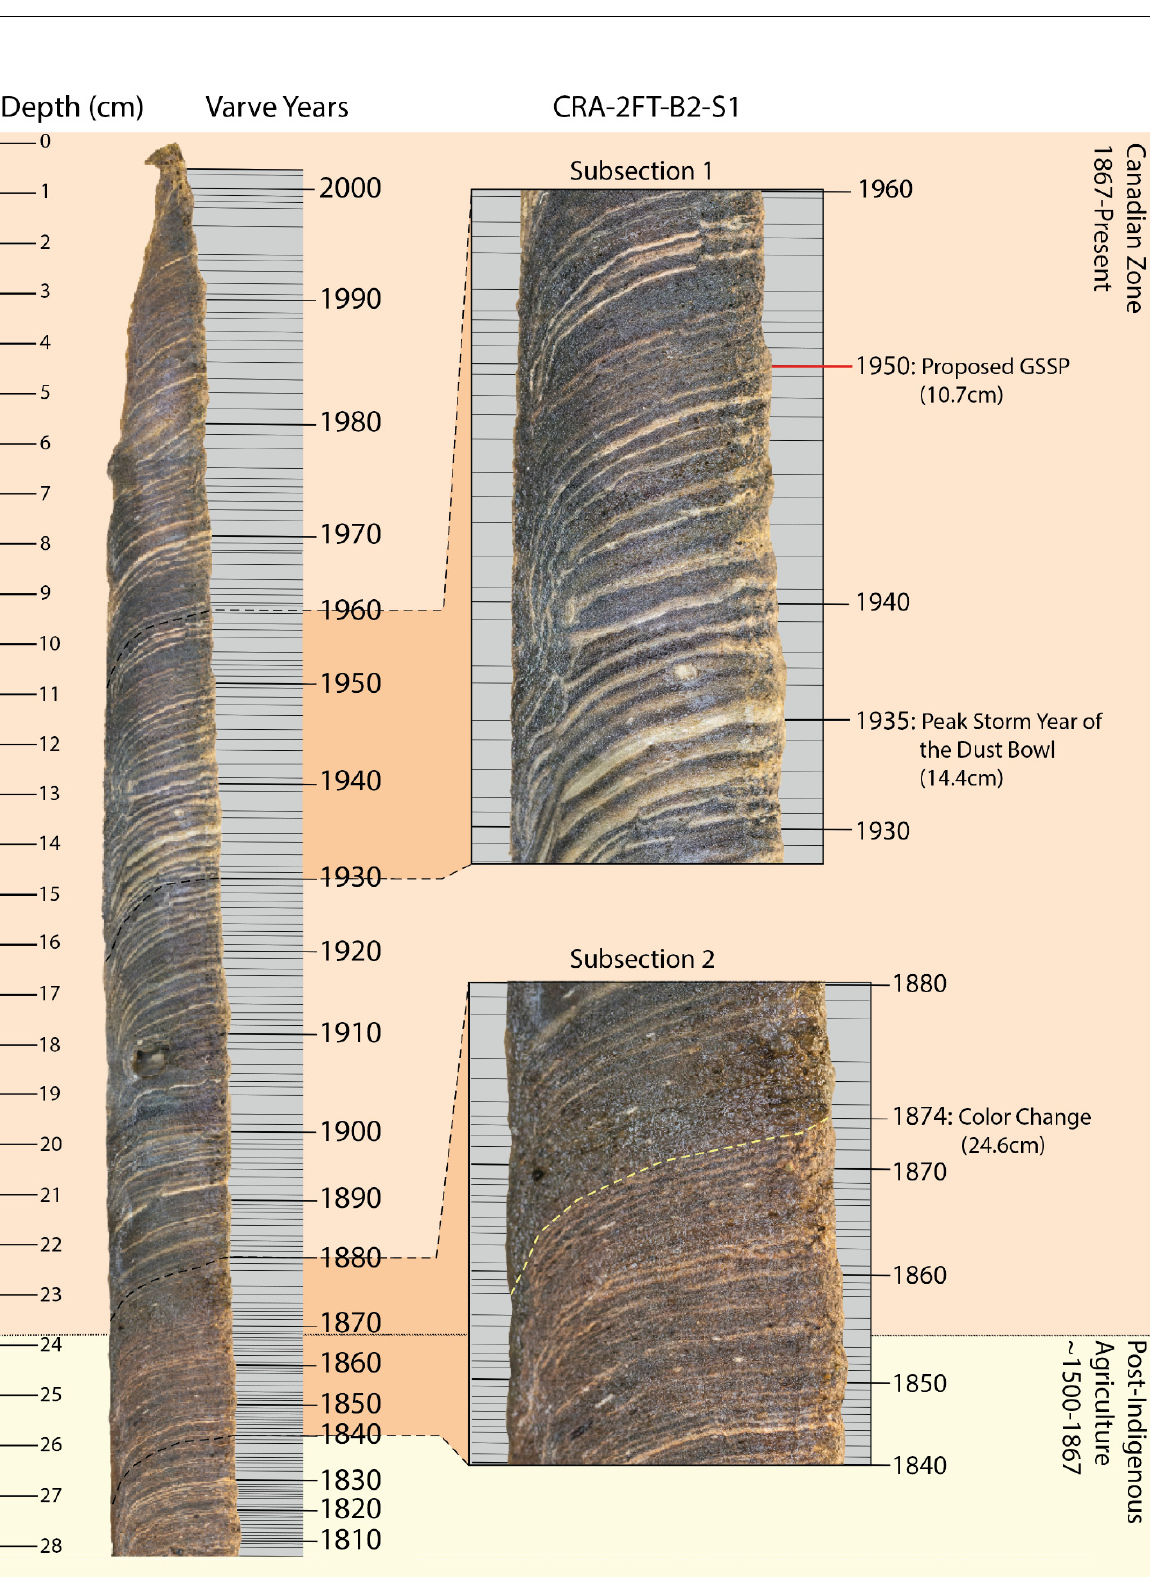
Figure 6. Chronology of varve sequence through the Canadian Zone (1867-Present) of freeze core CRA19-2FT-B2-S1. Note the warping of the flat laminae in cross section, reflecting very slow sinking of the lead-weighted freeze corer in the soft substrate as the sediments adhere to the metal.